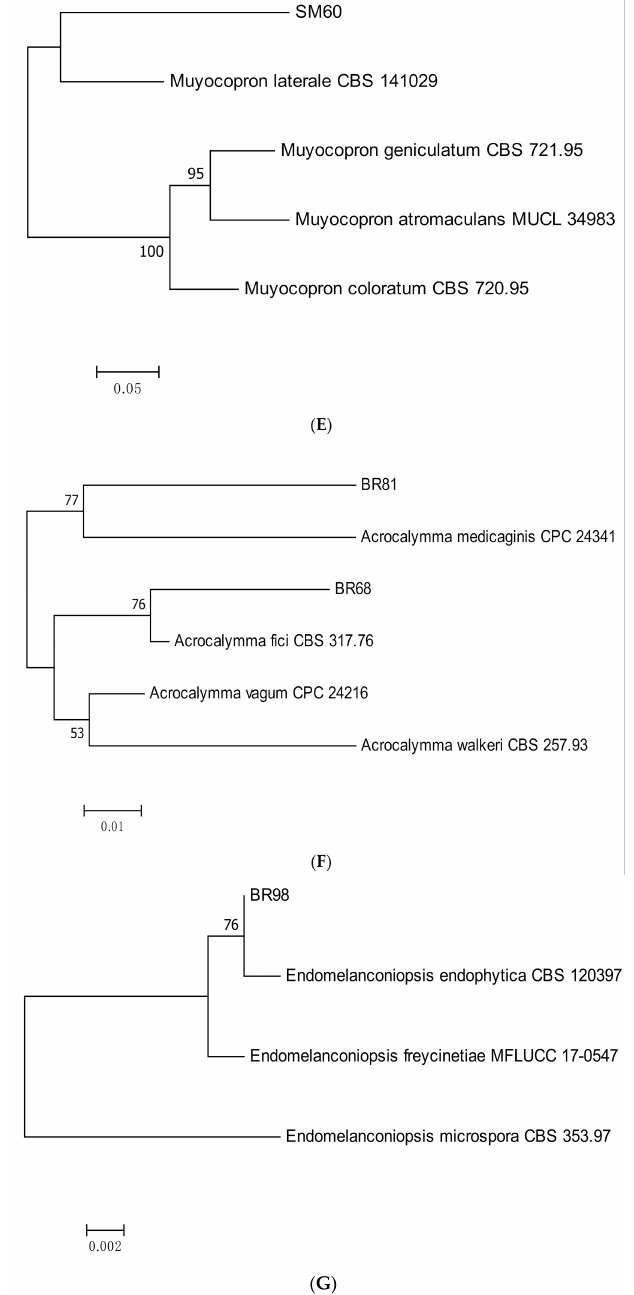
Figure 10. ( A – G ) Maximum likelihood tree inferred from combined sequences of ITS for ( A ) Curvu- laria lunata , ( B ) Bionectria pityrodes ( C ) Acremonium hennebertii , ( D ) Nemania primolutea , ( E ) Muyocopron laterale , ( F ) Acrocalymma spp., and ( G ) Endomelanconiopsis endophytica from C. castaneus spines of with bootstrap values higher than 50% are shown next to the